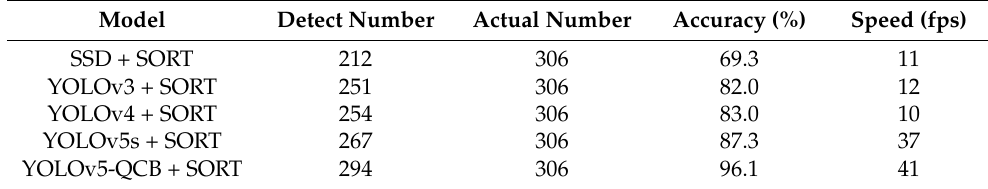
Table 7. Comparison of various detection models in conjunction with the SORT algorithm.